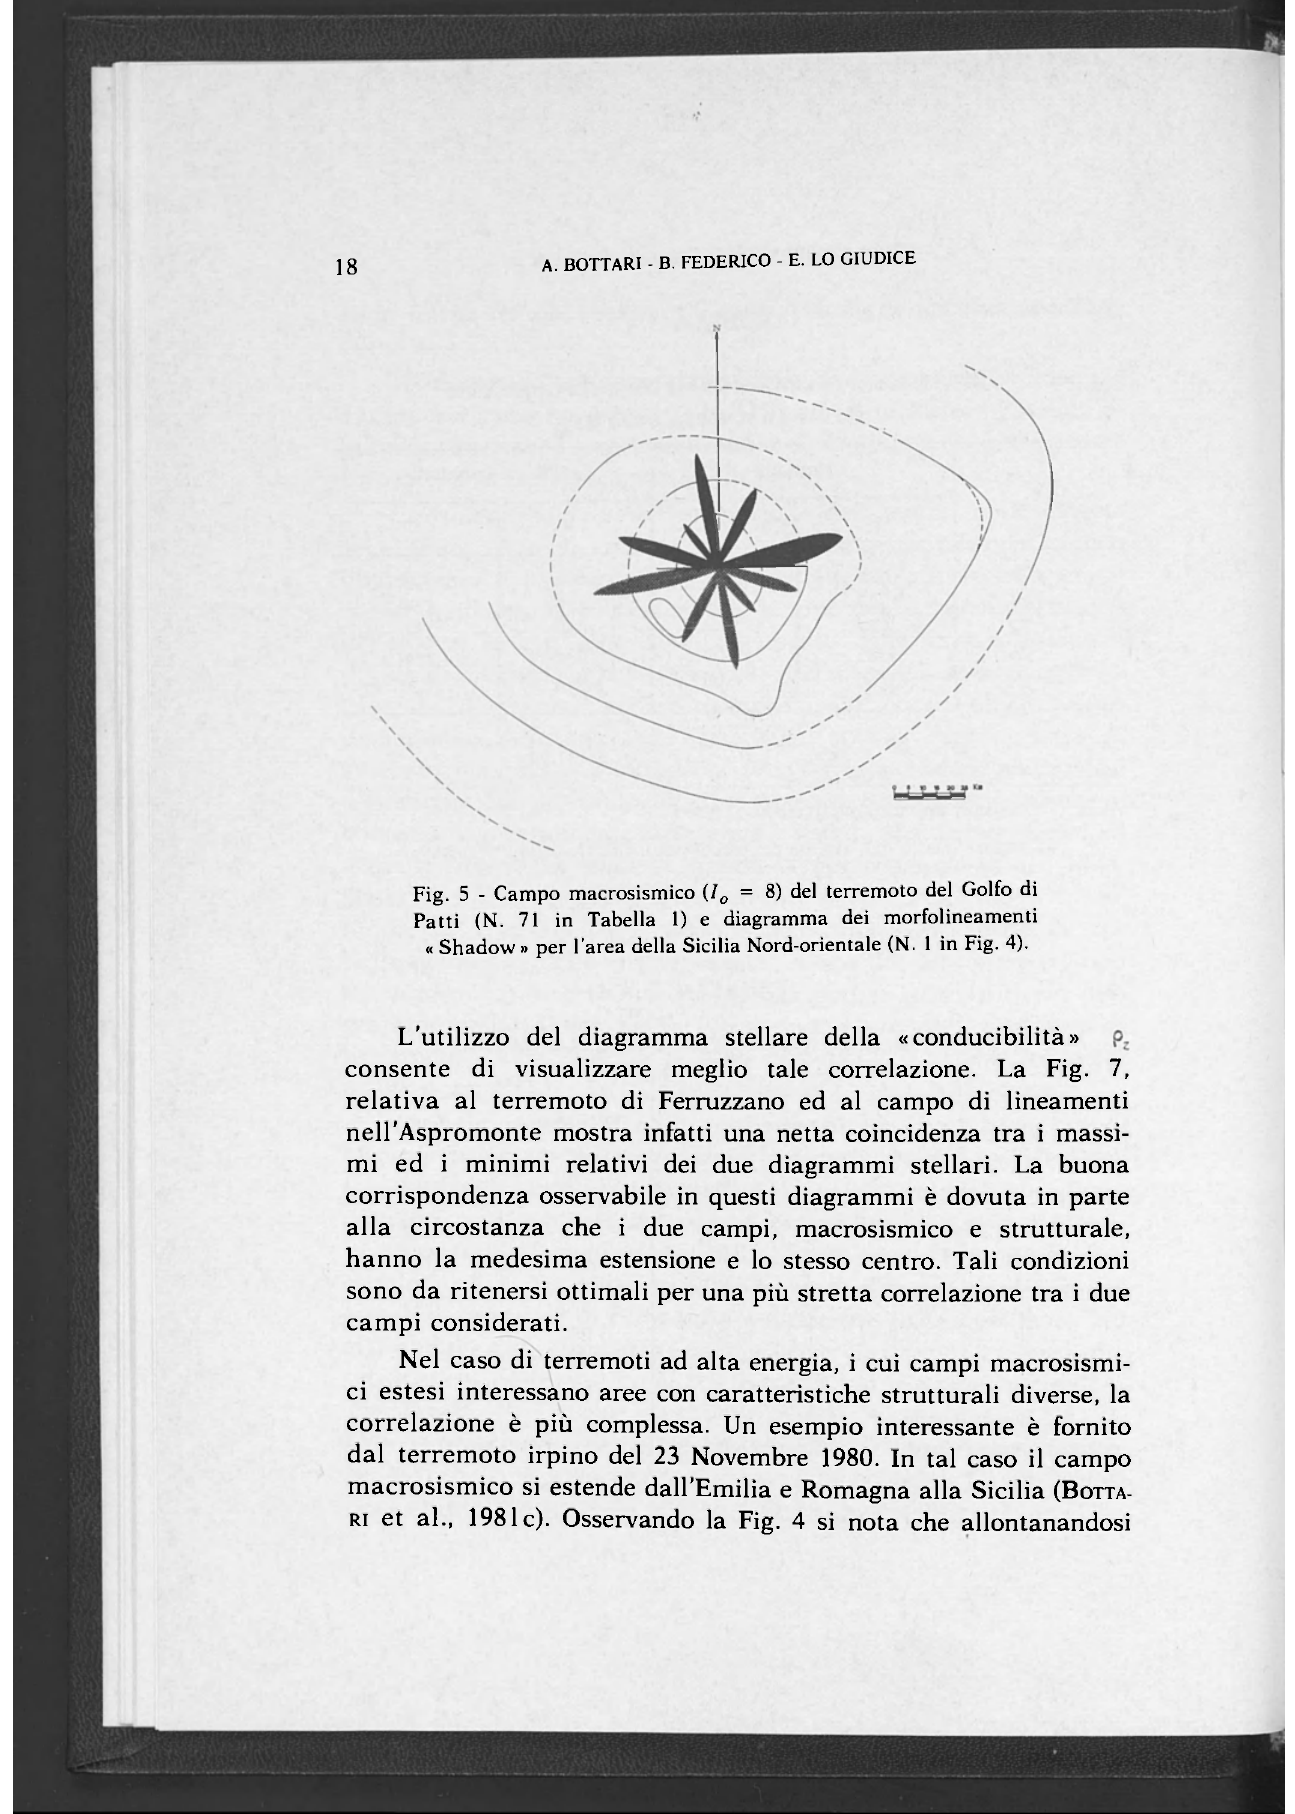
Fig. 5 - Campo macrosismico (I a = 8) del terremoto del Golfo di Patti (N. 71 in Tabella 1) e diagramma dei